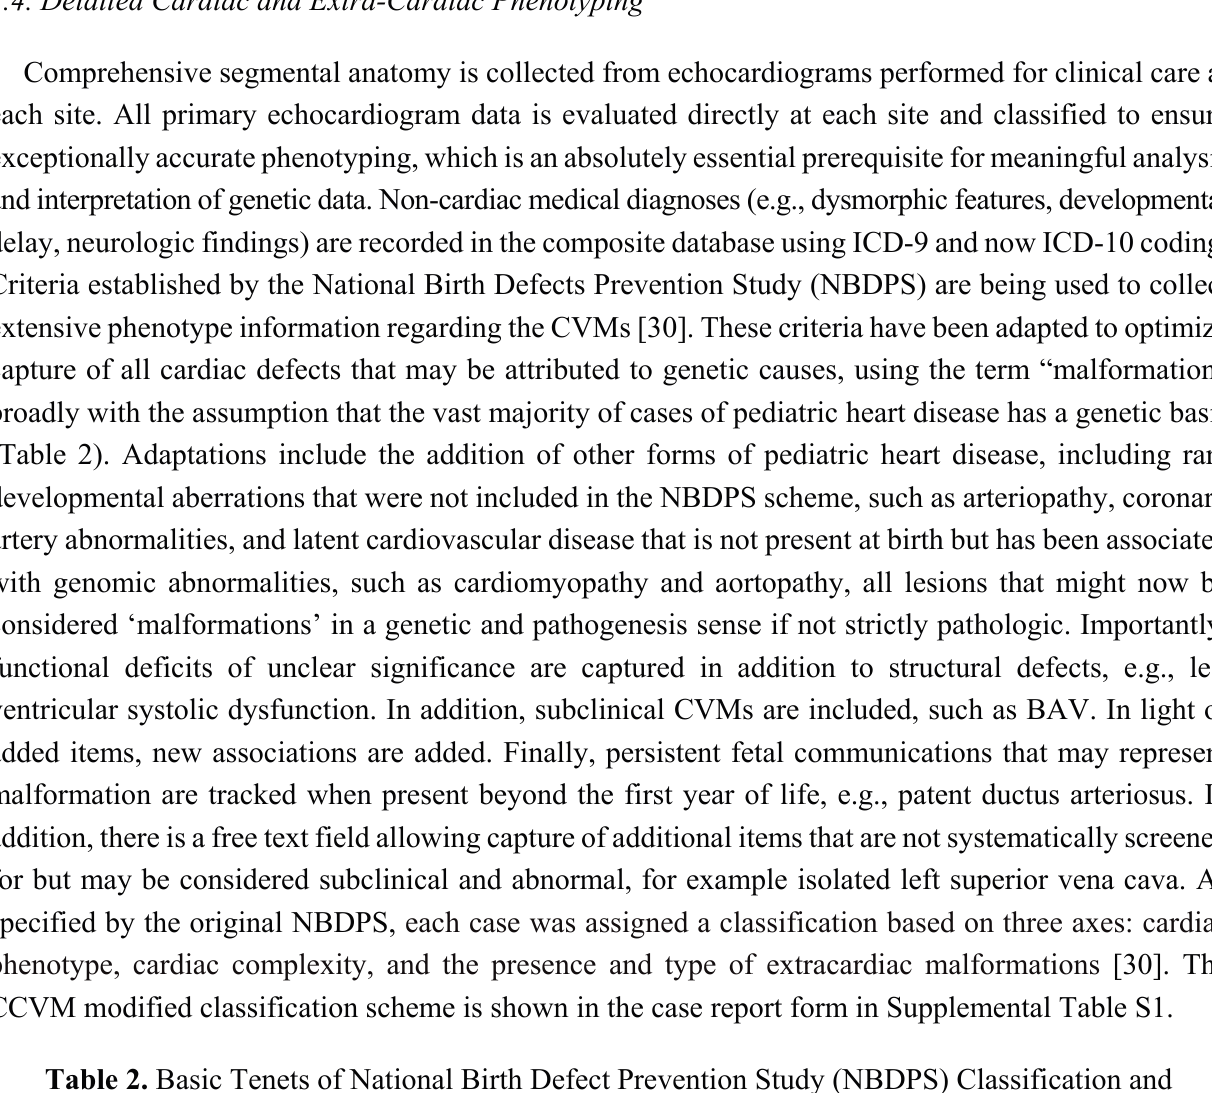
Table 2. Basic Tenets of National Birth Defect Prevention Study (NBDPS) Classification and Cytogenomics of Cardiovasscular Malformations (CCVM) Consortium